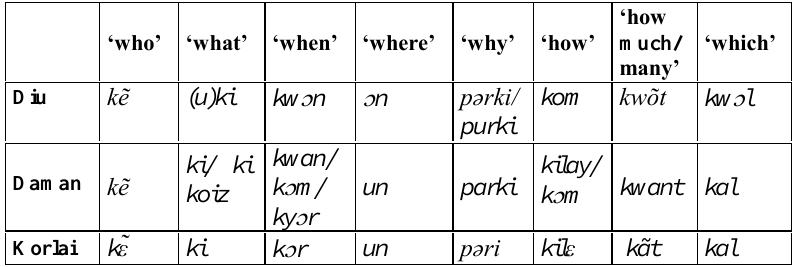
Table VIII. Question words in Diu, Daman, and Korlai (Cardoso, 2009: 130; and Clements & Mahboob, 2000: